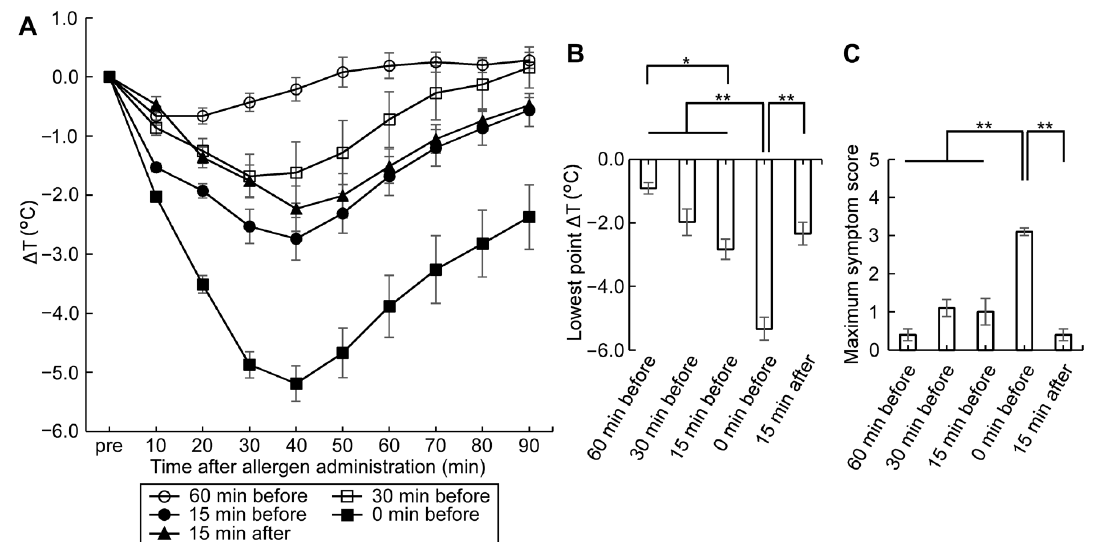
Figure 4. Optimal timing of ASA administration relative to oral allergen challenge. ( A ) Effects of sub- maximal dose at 50 mg/kg ASA before and after 20 mg OVM challenge on ΔT in sensitized mice; ( B ) Effects of timing of 50 mg/kg ASA medication on the lowest point ΔT in sensitized mice; ( C ) Effects of timing of 50 mg/kg ASA medication on the maximum symptom score in sensitized mice. Data are mean ± SEMs ( n = 10/group). * p < 0.05, ** p < 0.01.